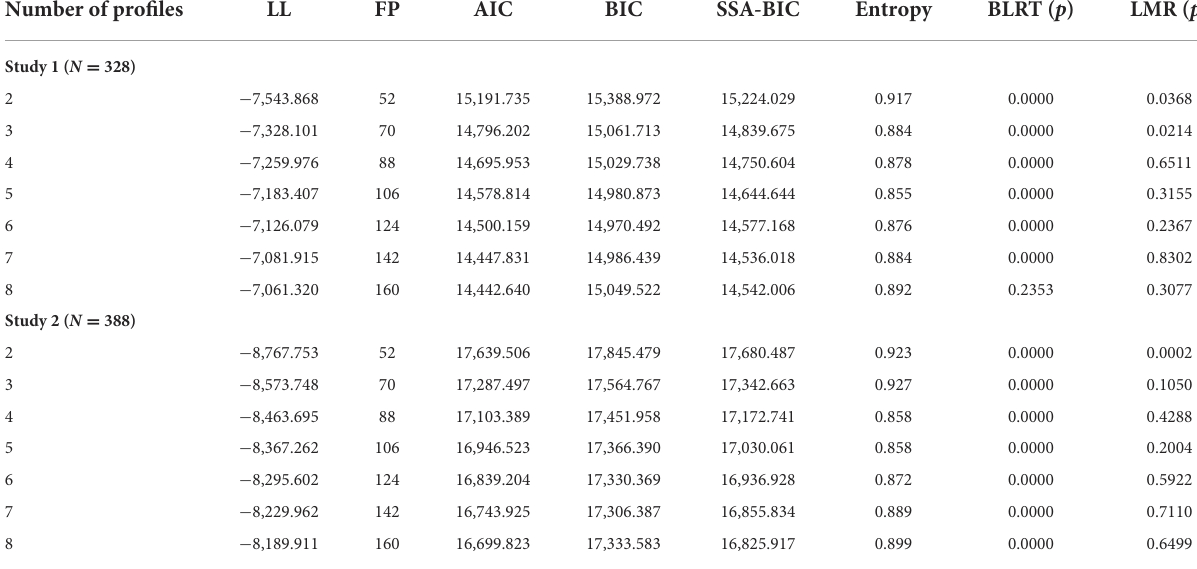
TABLE 3 Fit statistics for profile solutions in study 1 and study